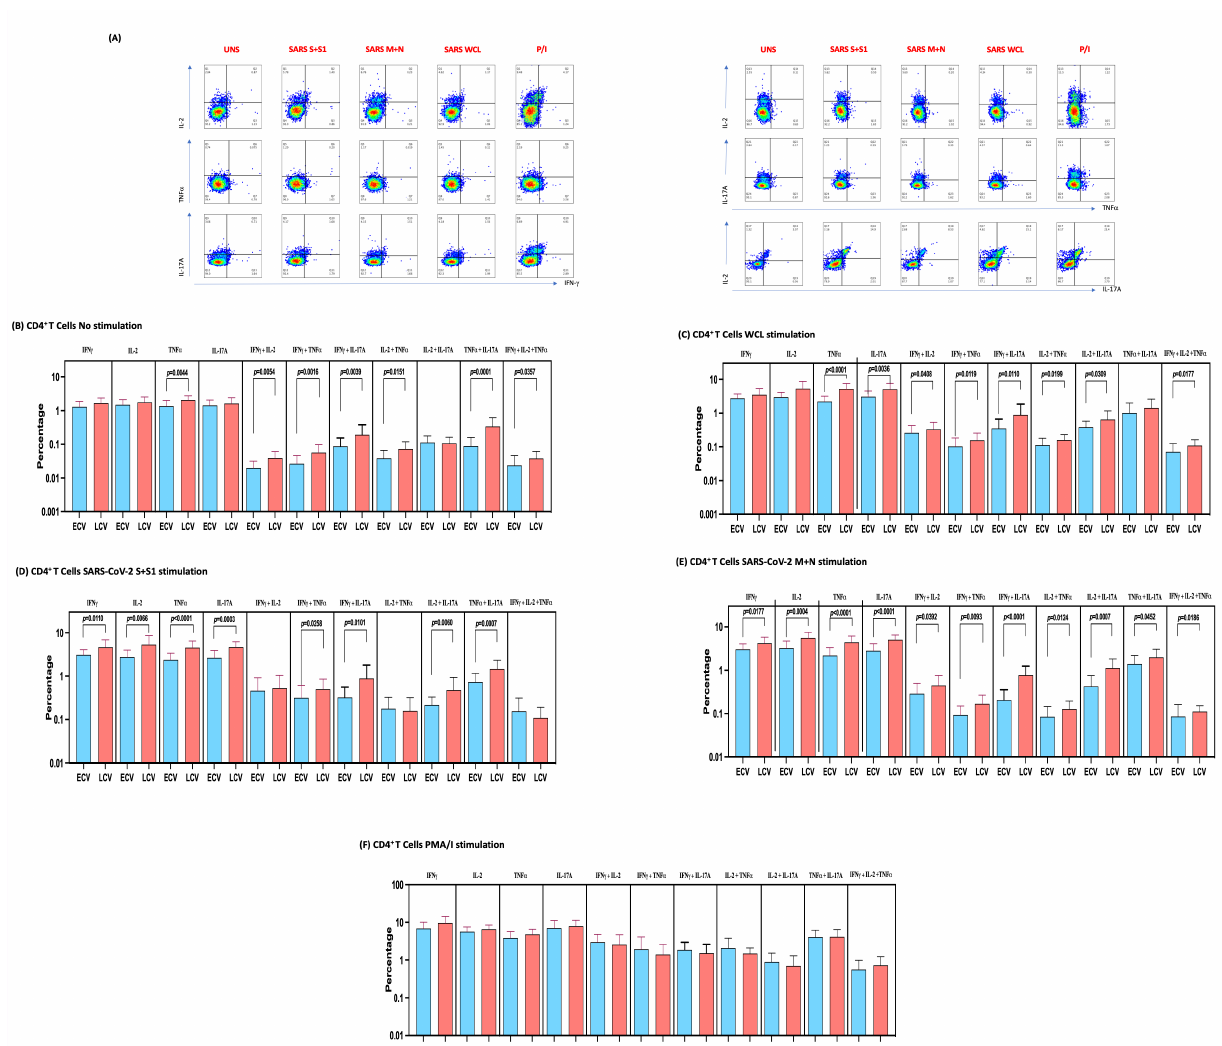
Figure 2. Enhanced frequencies of CD4 + T cells expressing multifunctional Th1 and Th17 cytokines in late convalescent COVID-19 individuals. PBMCs were cultured with media alone or SARS-CoV-2 or control antigens for 12 h and the baseline and antigen-stimulated frequencies of multifunctional Th1/Th17 cells were determined in determined in early convalescent (ECV) COVID-19 ( n = 20) and late convalescent (LCV) COVID-19 individuals ( n = 20). ( A ) Gating strategy and representative plots for Th1/Th17 CD4 + T cell subsets. The frequencies of mono-, dual- and multifunctional CD4 + Th1/Th17 cells in early convalescent and late convalescent individuals ( B ) At baseline as well as in response to stimulation with ( C ) SARS-CoV-2 WCL, ( D ) SARS-CoV-2 S+S1 peptide pools, ( E ) SARS-CoV-2 M+N peptide pools and ( F ) PMA/Ionomycin were measured by flow cytometry. The bars represent the geometric mean values. Net frequencies were calculated by subtracting baseline frequencies from the antigen- induced frequencies for each individual. p values were calculated using the Mann–Whitney test. Any comparison that is not labelled with a p value is statistically